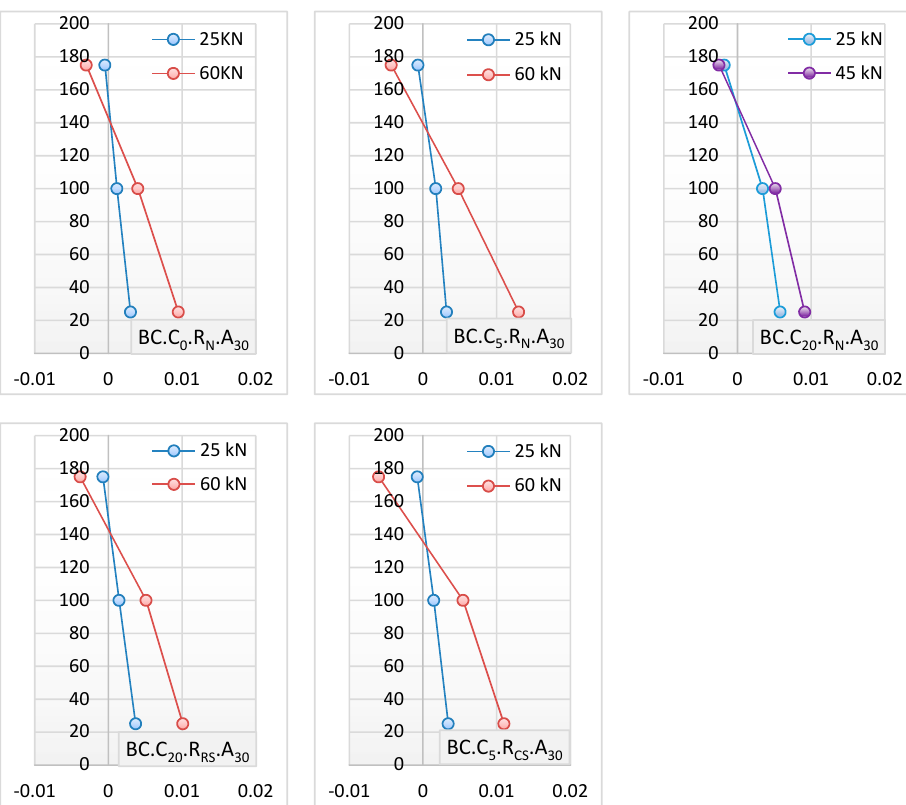
Figure 9. Concrete strain for specimens in Group B.